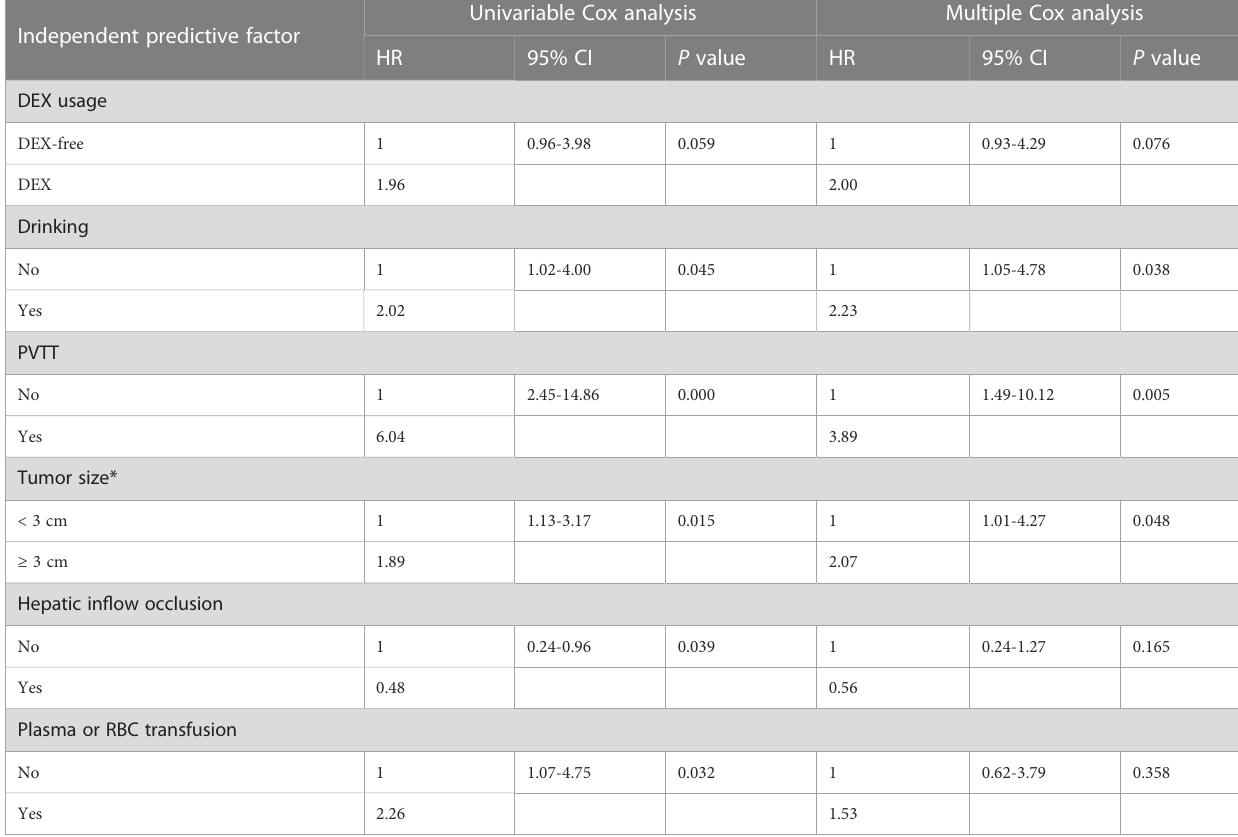
TABLE 3 Univariable and multivariable Cox regression model analysis of OS in patients after PSM. Univariable Cox analysis Multiple Cox Independent predictive factor